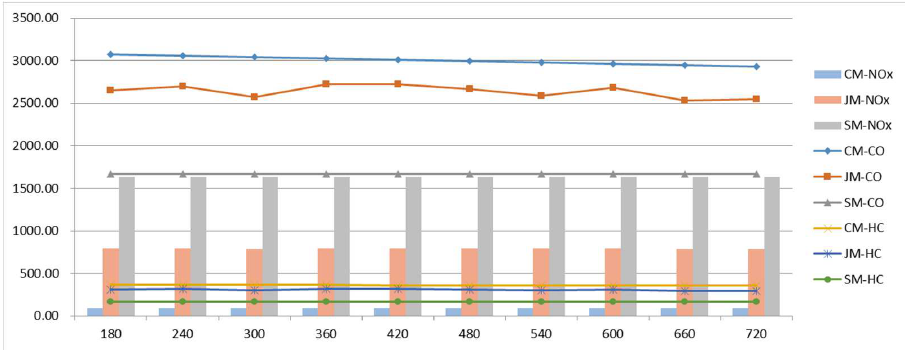
Figure 11. Pollutant emissions variations with parameter Δ t .